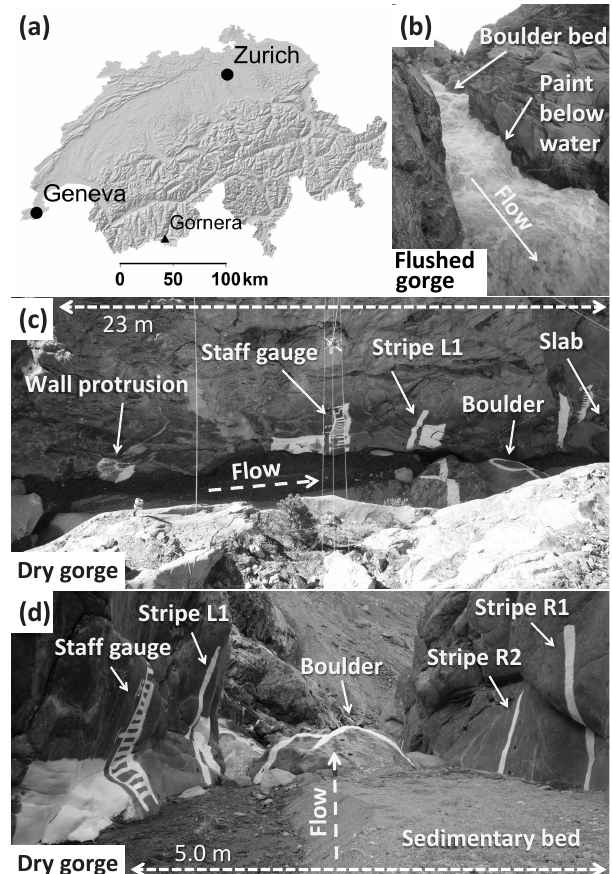
Figure 1. The demonstration field site for bedrock erosion paint- ing: (a) the location of the Gornera proglacial stream, Switzerland, (b) lateral view of the bedrock gorge reach during flushing of the sediment retention basin upstream, (c) top view of the gorge reach during dry conditions, showing some eroded painted surfaces on the left wall and in the stream bed, and (d) downstream view in the gorge reach under dry conditions, showing some of the refreshed painted surfaces. Only the paint areas that are indicated and named are used for analysis